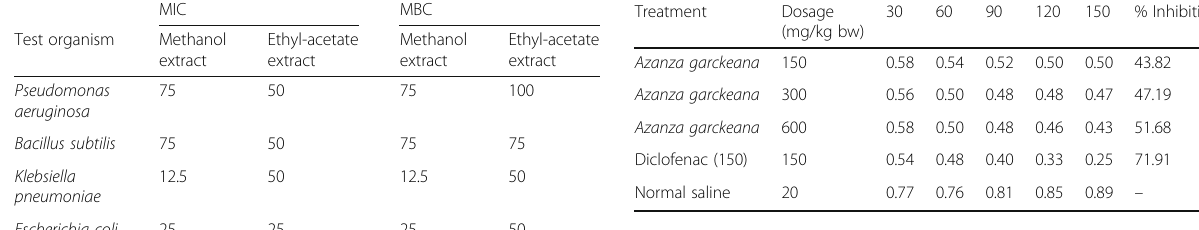
Table 6 Minimum inhibitory and minimum bactericidal concentration of methanol and ethyl-acetate extracts of Azanza garckeana against some pathogenic organism Test organism